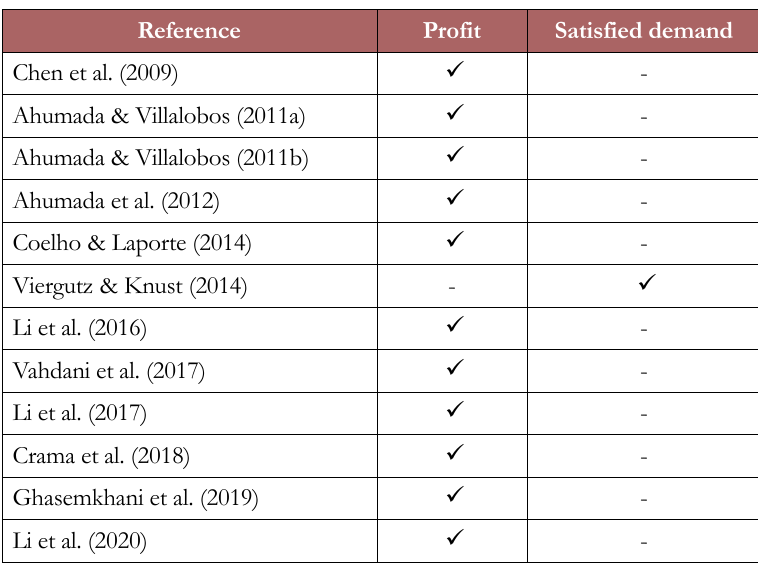
Table 10. Mono-objective maximization